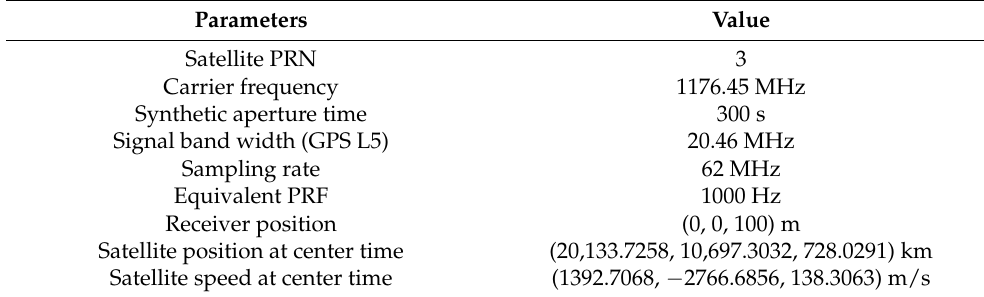
Figure 6. Layout of the point targets in simulation and the imaging results. ( a ) is the distribution of the simulation scene, and ( b ) is the imaging results with improved BPA on CPU and GPU. Table 1. Simulation parameters.